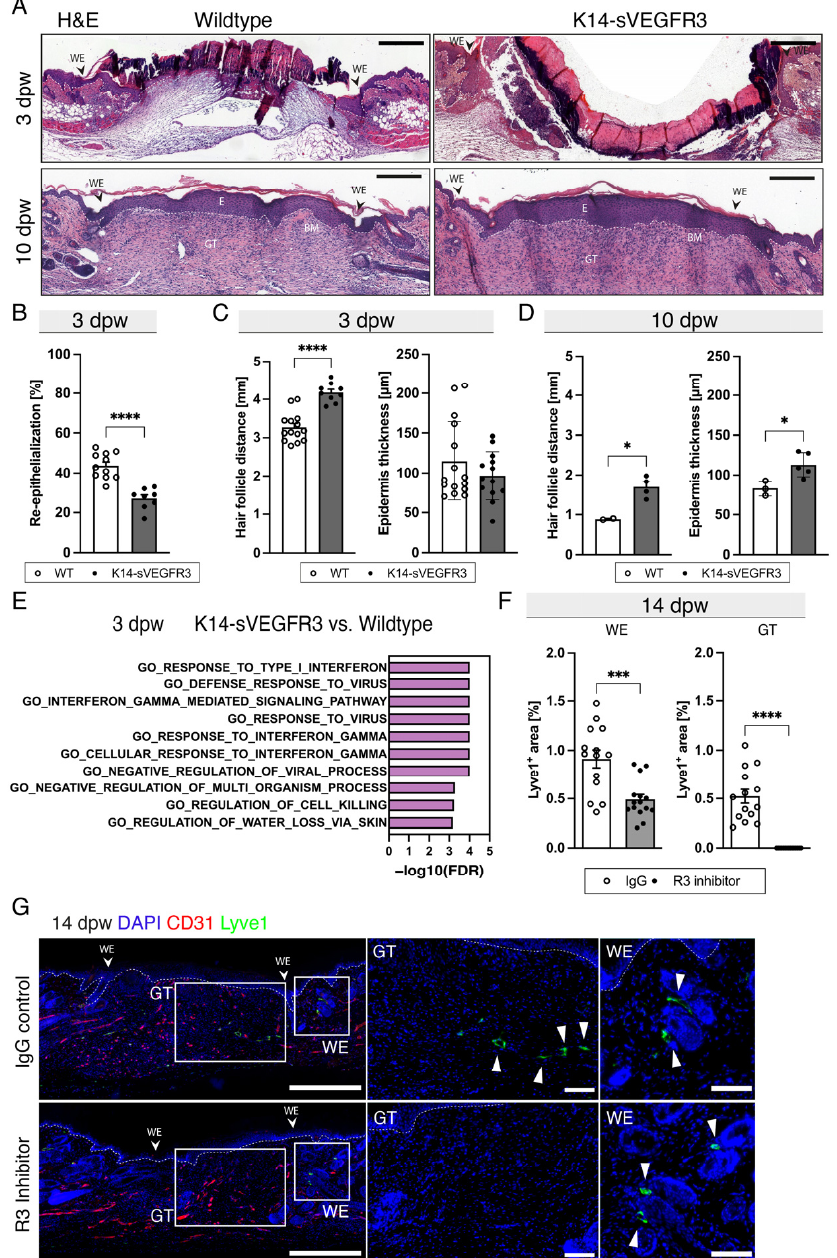
Figure 3. Lack of lymphangiogenesis delays wound closure and blocking of VEGFR3 completely inhibits lymphangiogenesis. ( A ) H&E representative sections of WT and K14-VEGFR3-Fc transgenic mice at 3- and 10-dpw. Scale bar: 500 µ m. 8–11 wounds of 5 mice. ( B ) Re-epithelialization [%] of